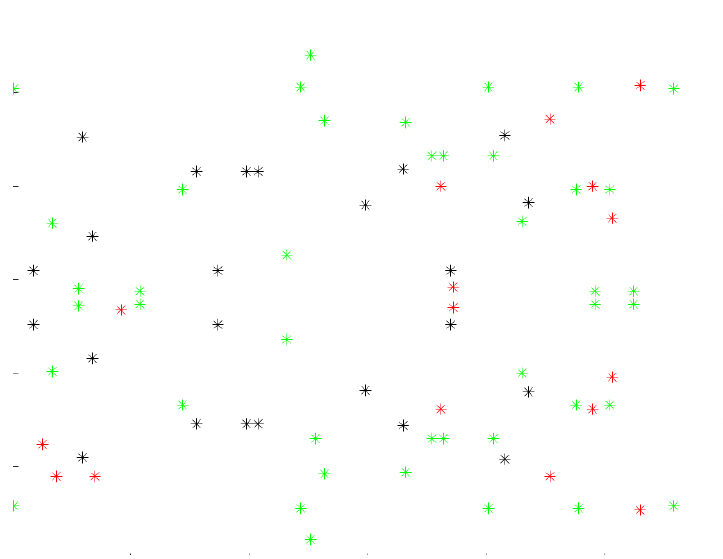
Figure 3. Cryptographic point